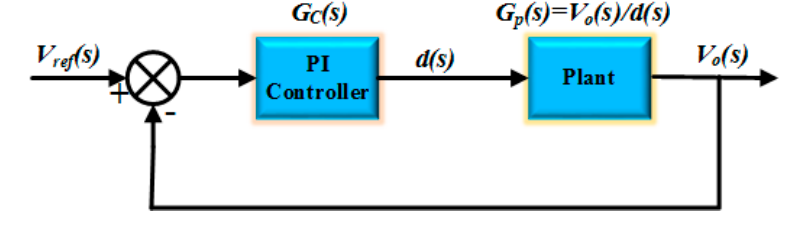
Figure 5. Voltage control loop.